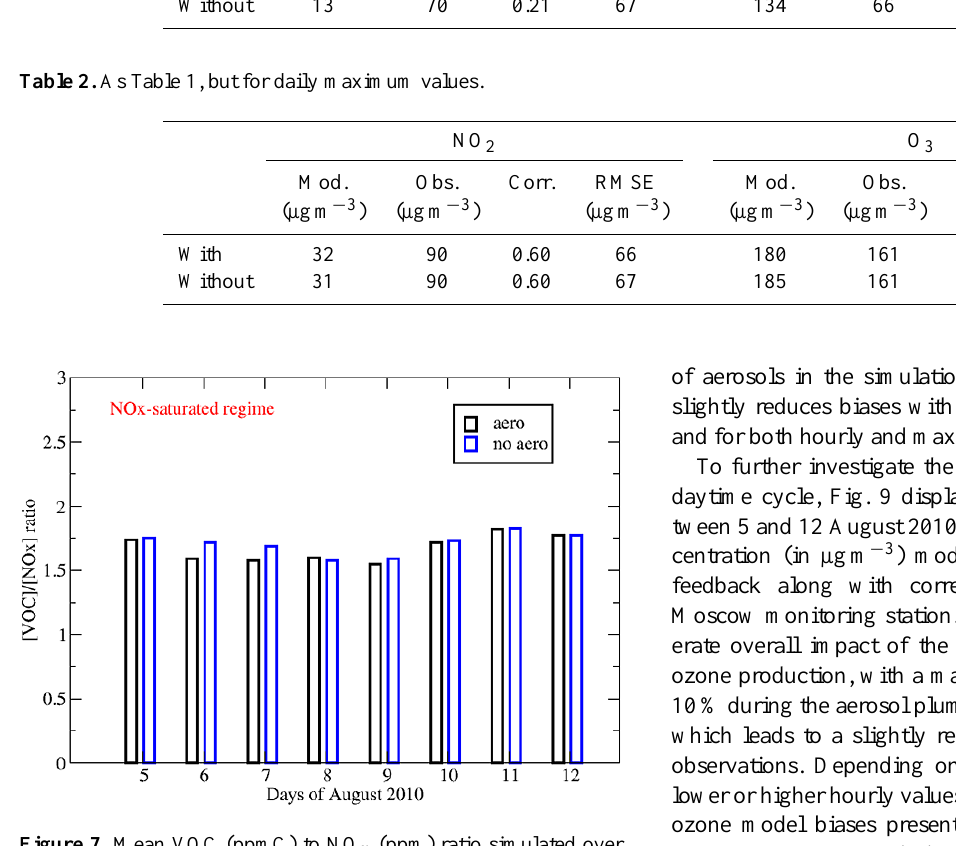
Figure 7. Mean VOC (ppmC) to NO x (ppm) ratio simulated over Moscow during the studied